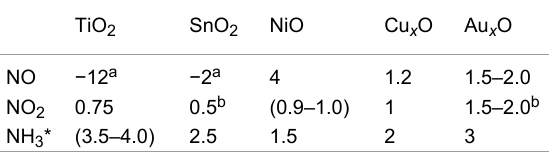
Table 2: Relative increase or decrease in resistance (decrease or increase in conductance) of TiO 2 , SnO x , NiO, Cu x O, and gold clus- tered oxide, Au x O treated “n-type” PS interfaces. The table constitutes a response matrix for the gases NO, NO 2 , and NH 3 . For the data presented for NO see Figure 8.